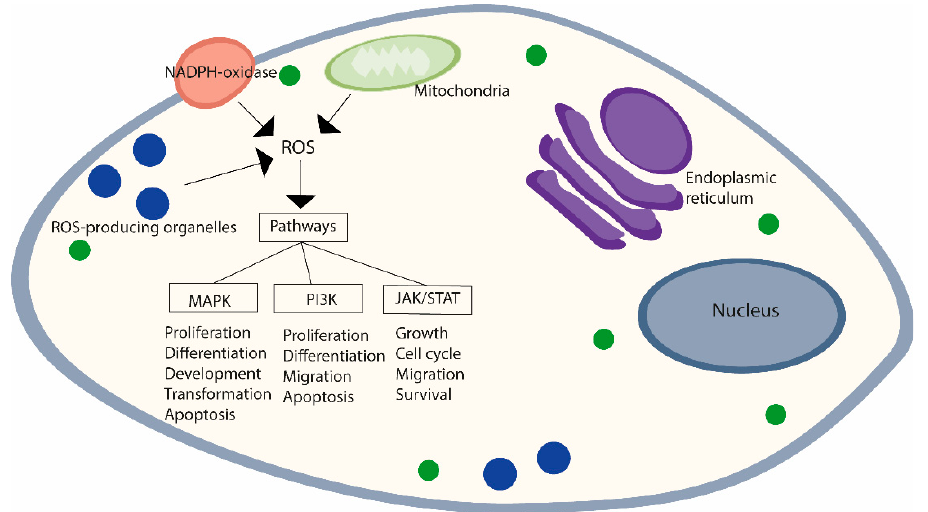
Figure 1. ROS-mediated activation of cell signaling pathways. Major sites of reactive oxygen species (ROS) production in cells, enzymes responsible for ROS production at each of the cellular compartments, and principal signaling pathways activated.